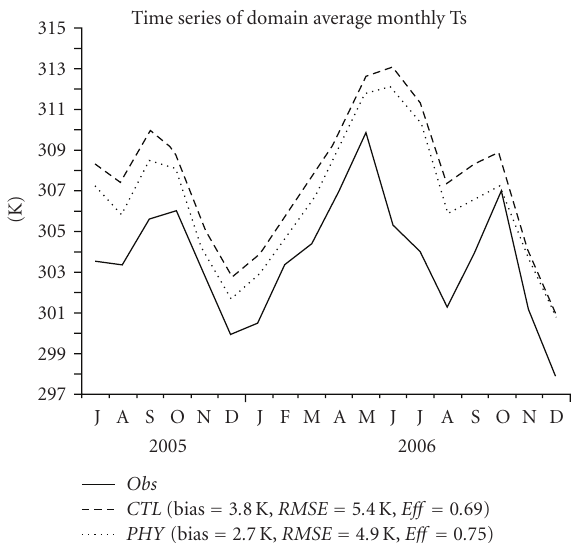
Figure 4: Comparison between the simulated and MSG/SEVIRI estimated monthly surfaces temperatures over Dantiandou Kori. The Bias, RMSE , and E ffi ciency ( E ff ) statistics calculated at a 3-hour time step are also given.